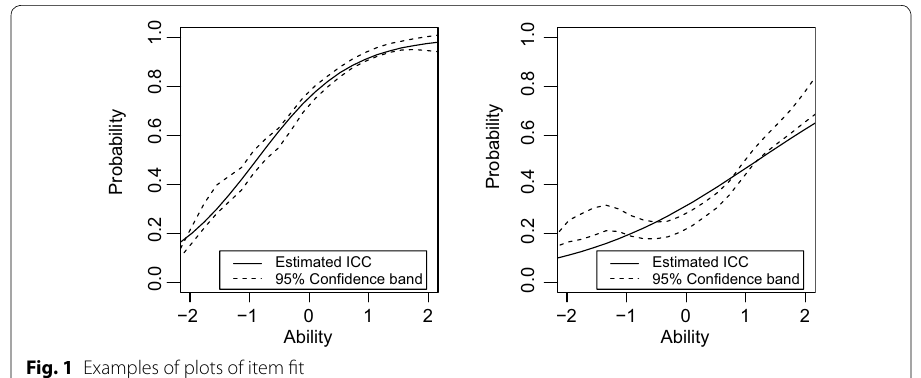
Fig. 1 Examples of plots of item